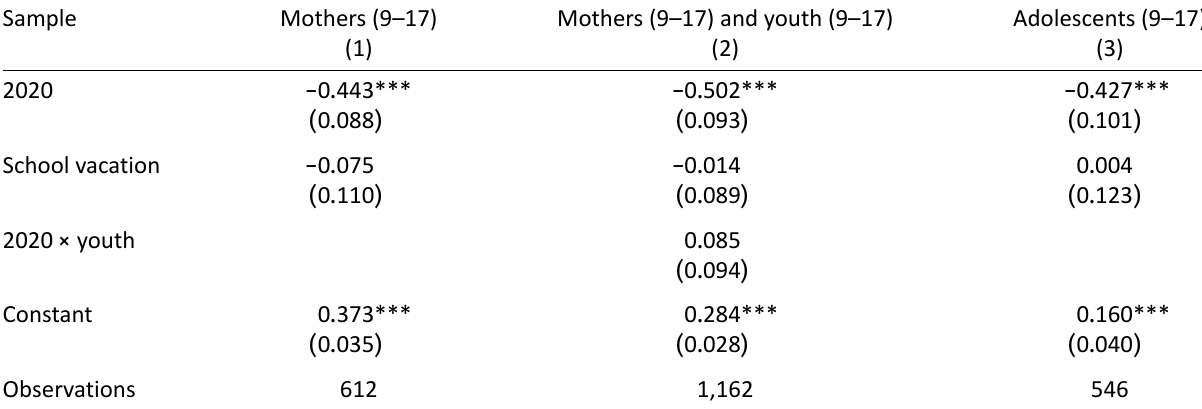
Table 2. Changes in family climate between 2019 and